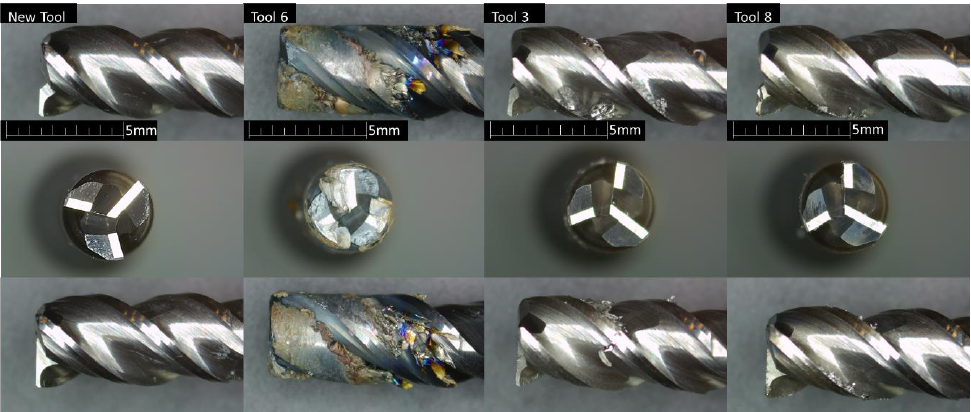
Figure 7. Tool wear after the test.